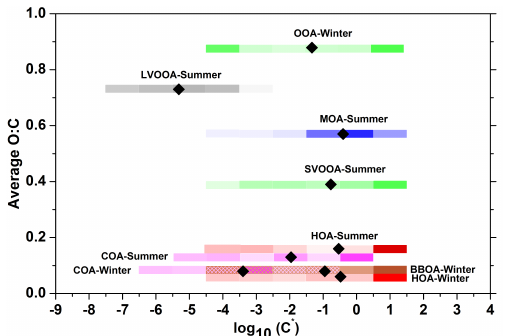
Figure 8. 2D-VBS representation of the PMF factors for the sum- mer and winter campaigns. With the red color of the bars we repre- sent the HOA factors, with the pink color the COA factors, the green the SVOOA and OOA, the blue is for the MOA factor, the brown for the BBOA factor and the black for the LVOOA factor. The darker shading of the colored bars denotes a larger mass fraction for a given C ∗ bin. The diamond represents the average log 10 (C ∗ ) value for a given PMF